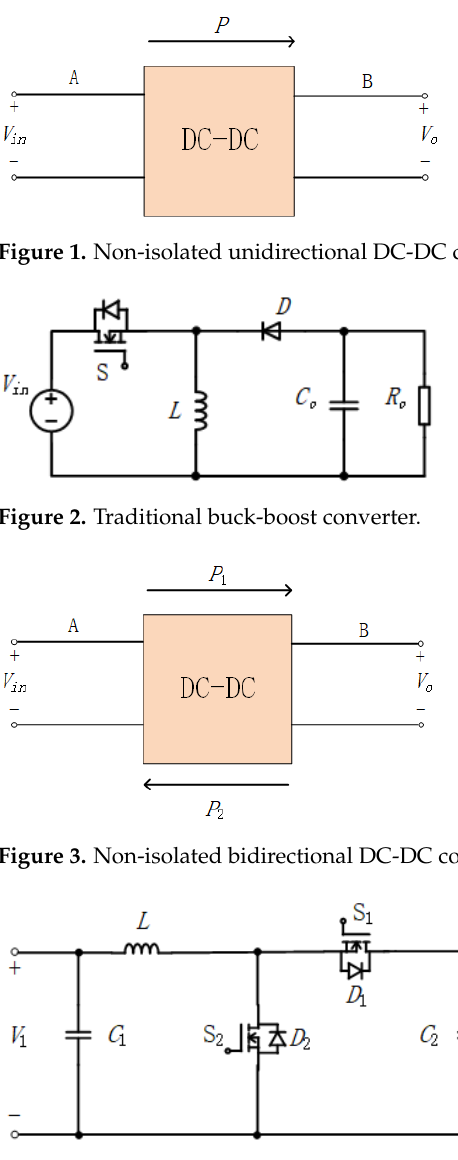
Figure 4. Traditional bidirectional buck-boost converter.